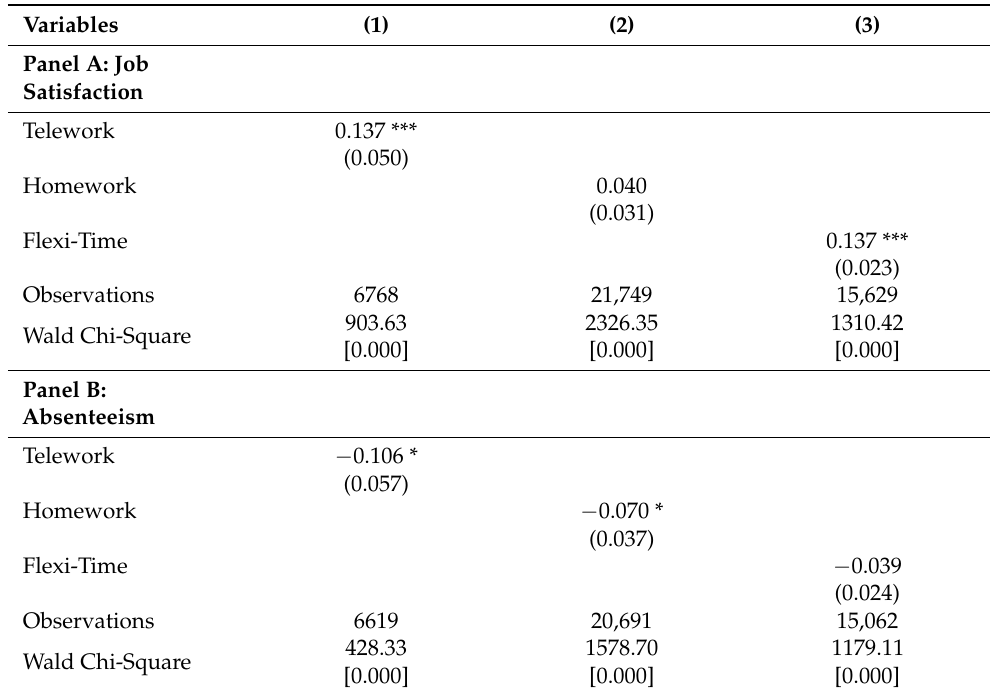
Table 8. Flexible Employment Schemes, Job Satisfaction and Absenteeism for